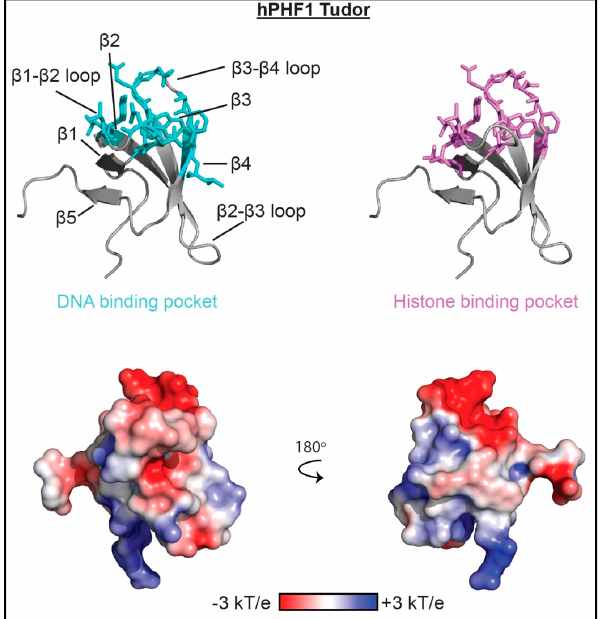
Figure 6. The molecular mechanism of Tudor association with nucleic acid. Residues determined to be important for binding nucleic acid as mapped by NMR spectroscopy and/or mutagenesis are shown as cyan sticks on ribbon representations of the PHF1 Tudor structure (PDBID 4HCZ). Residues important for histone binding are shown as violet sticks. Corresponding representation of the electrostatic surface (determined using the APBS plug-in in pymol) is shown in two